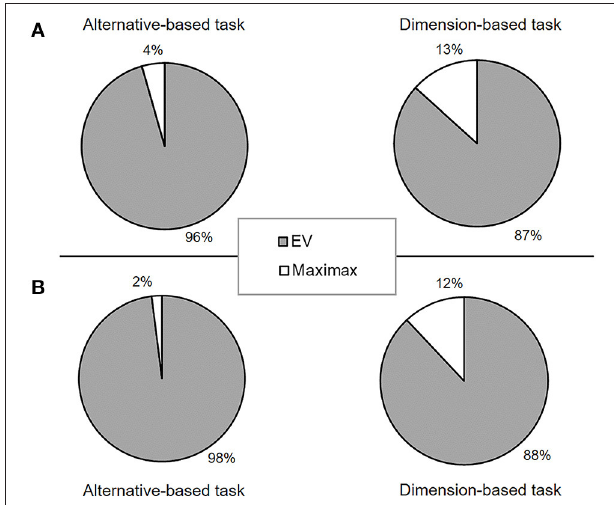
FIGURE 2 | Proportion of participants classified as following the EV strategy and the maximax heuristic strategy, classified separately for the alternative-wise and the dimension-wise tasks in (A) Experiment 1 and (B) Experiment 2,